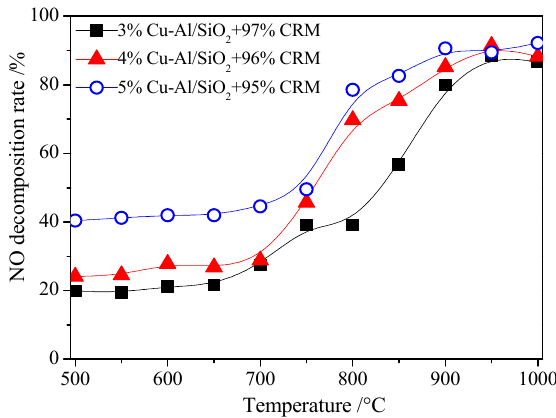
Figure 5. Effect of adding different amounts of Cu-Al/SiO 2 material in cement raw materials (CRM) on NO decomposition rate.